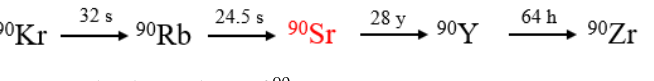
Figure 1. The decay chain of 90 Sr.